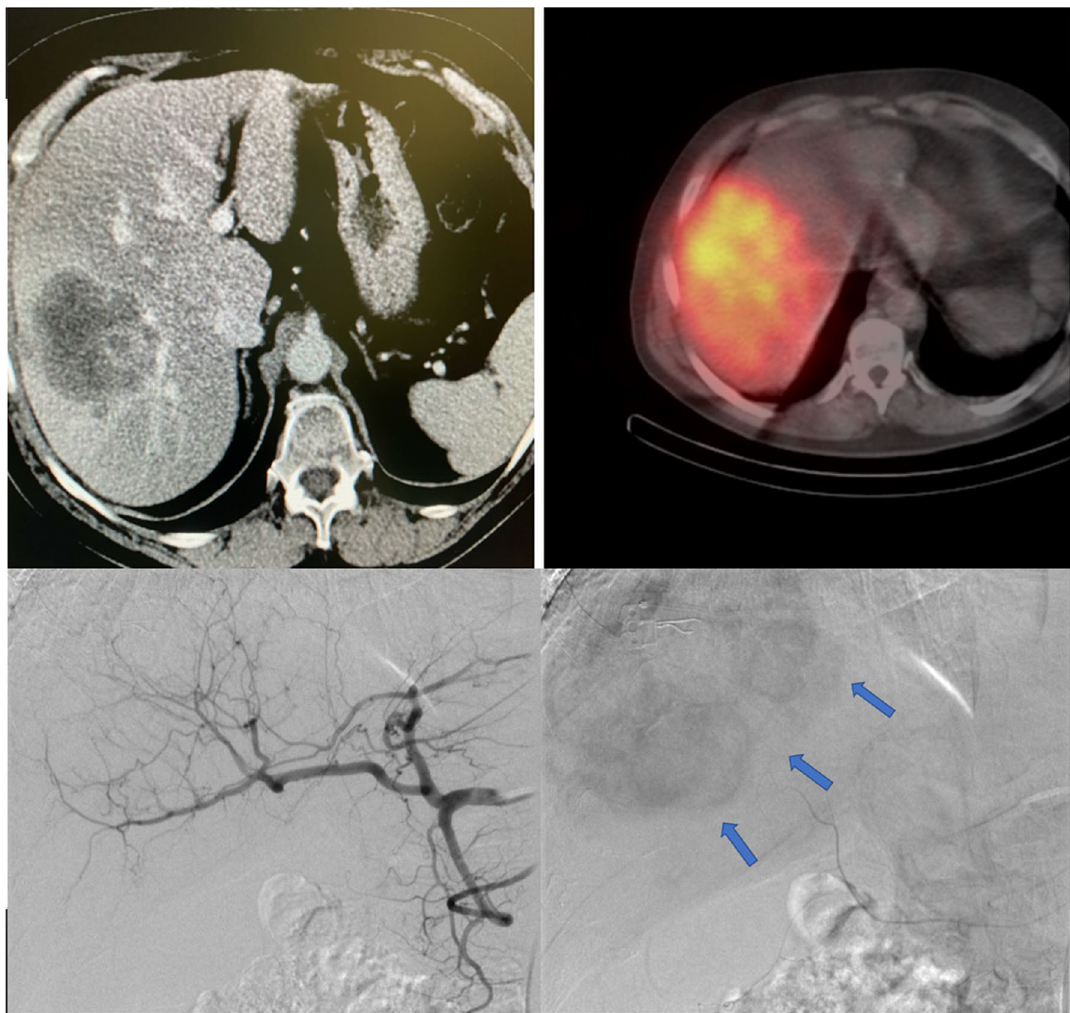
of hepatic arteries and hepatic tumors contrast enhancement—blue arrows ( C , D ). Images of one of the patients treated with radioembolization in our center (with